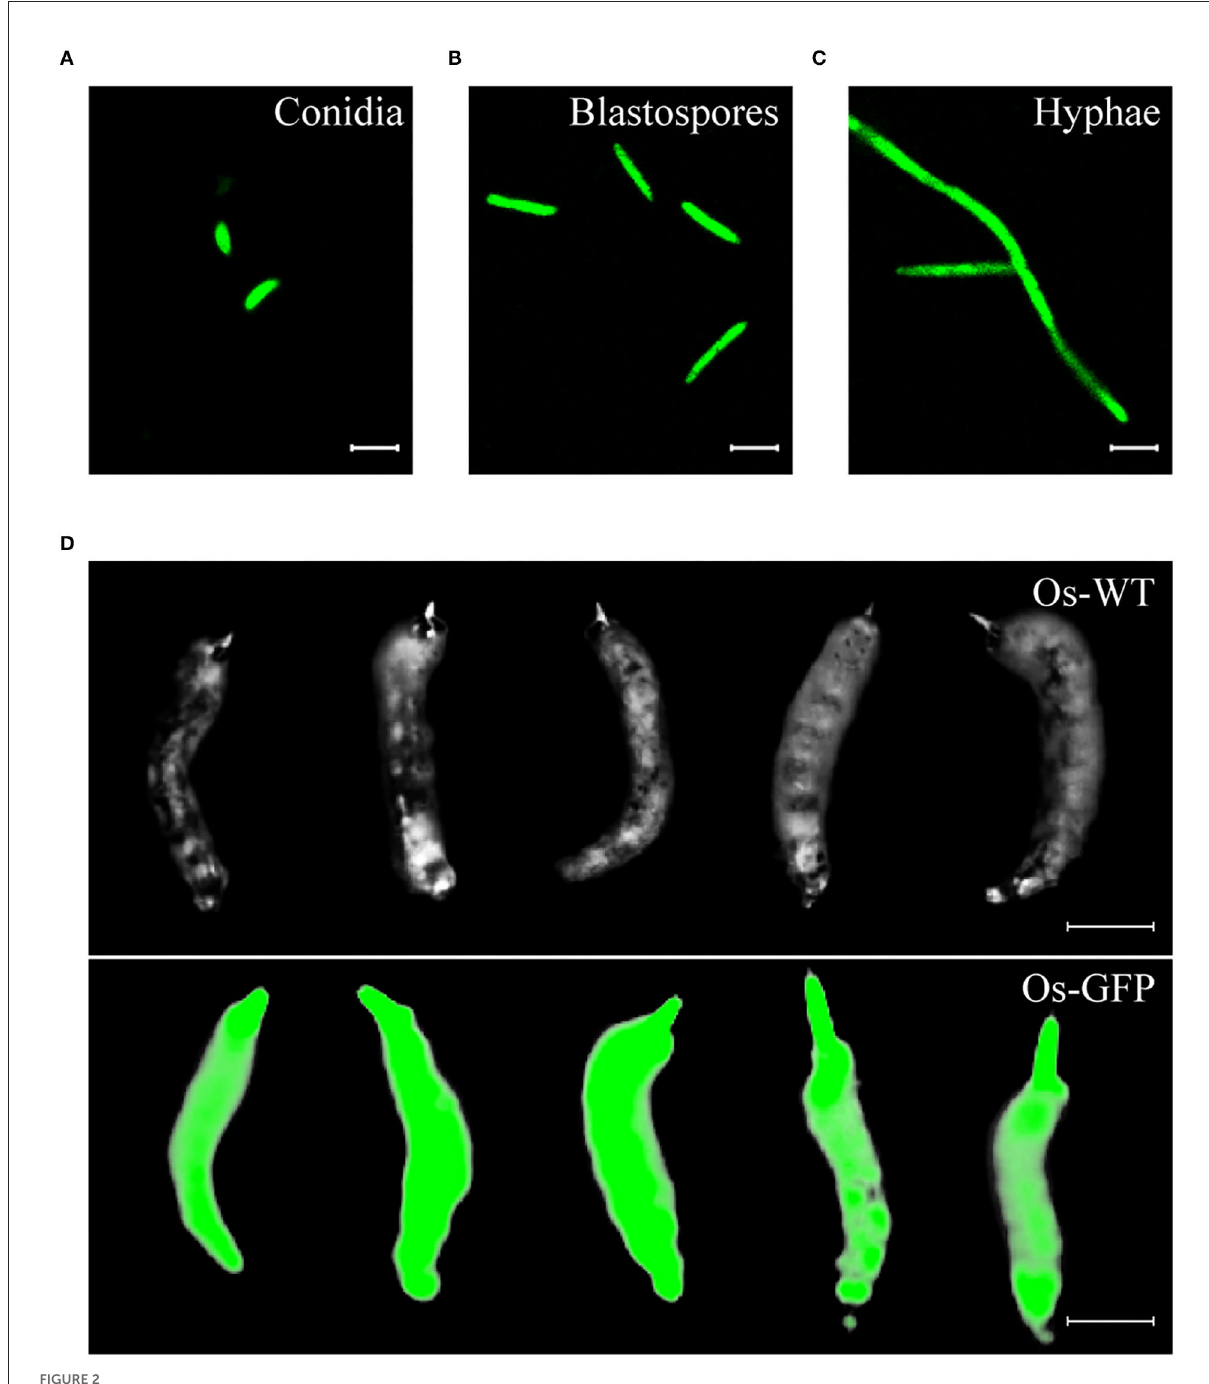
FIGURE2 The Ophiocordyceps sinensis transformant generated with the pBHt2-OsPEF1 α vector constitutively expressed green fluorescent protein. Conidia (A) , blastospores (B) , and hyphae (C) of the GFP-labeled O. sinensis strain were visualized at a 488-nm excitation wavelength. (D) Chinese cordyceps derived from the GFP-labeled O. sinensis strain still had a green fluorescent signal. Scale bars in (A–C) , 10 µ m. Scale bar in (D) ,